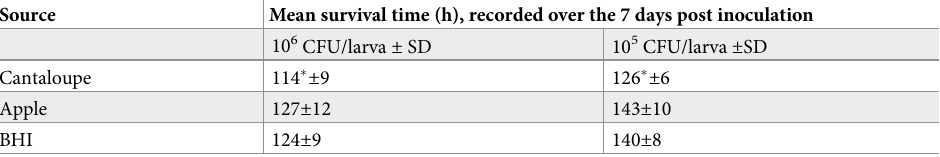
Table 3. Mean survival time of G . mellonella larvae at 37˚C: After inoculation with L . monocytogenes strains grown in BHI, on apple, or on cantaloupe fragments. The results were averaged across all strains. The table present the results with the standard deviations.